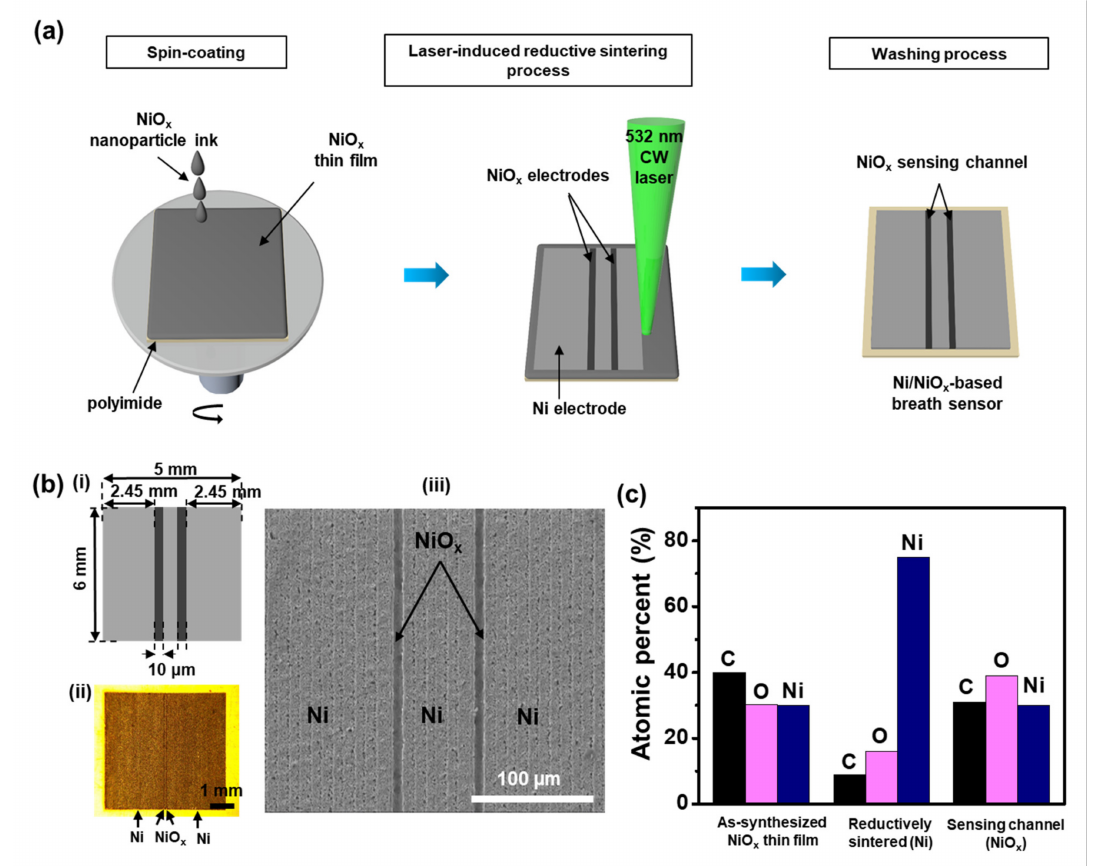
Figure 2. ( a ) Schematic of the fabrication procedures of the flexible Ni/NiO x -based breath sensor on polyimide (PI). ( b ) (i) Schematic drawing, (ii) optical microscopy image, and (iii) scanning electron microscopy (SEM) image of the Ni/NiO x -based breath sensor. ( c ) Chemical compositions of the as- synthesized NiO x thin film, reductive sintering Ni electrode, and the NiO x -sensing channel, analyzed by energy-dispersive X-ray